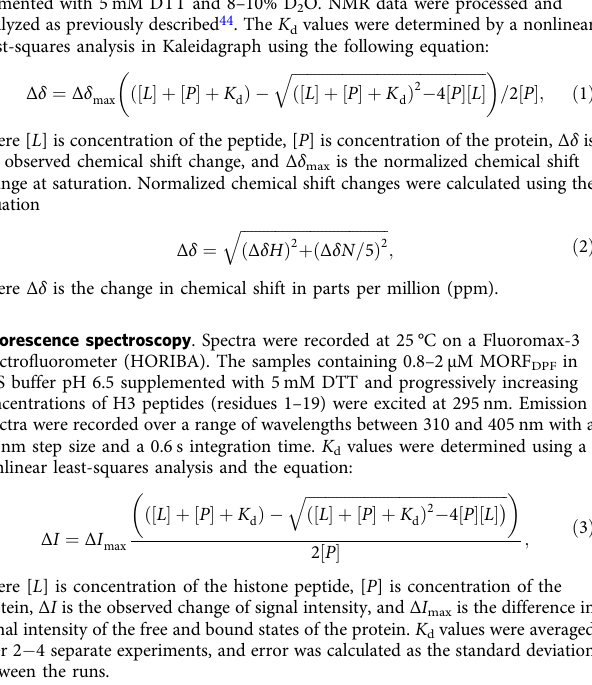
Alternatively, reactions were stopped by adding Laemmli sample buffer, run on SDS- PAGE, stained with coomassie, treated with EnH 3 ance, dried and expose on fi lm for fl uorography (Supplementary Fig. 1c). In Fig. 4e and Supplementary Fig. 7, puri fi ed MORF proteins were incubated at 37°C for indicated times with peptides (1 μ g) and 0.1 mM acetyl-CoA in HAT reaction buffer (50 mM Tris, pH 8.0, 0.1mM EDTA, 10% glycerol, 1 mM PMSF, and 1mM DTT) in a total volume of 50 μ L. Reactions were quenched by fl ash- freezing in liquid nitrogen and then analyzed by SDS-PAGE and Western blot. Protein puri fi cation . MORF DPF mutants (F287A, D289A, F218A, R276E, R306E/ K309E, and F287A/R306E/K309E) were generated using the Quick Change site- directed lightning mutagenesis protocol (Stratagene) (Supplementary Table 2). Unlabeled and 15 N-labeled WT and mutated MORF DPF (residues 211 – 322) were expressed in E. coli Rosetta2 (DE3) pLysS cells grown in LB or NH 4 Cl (Sigma-